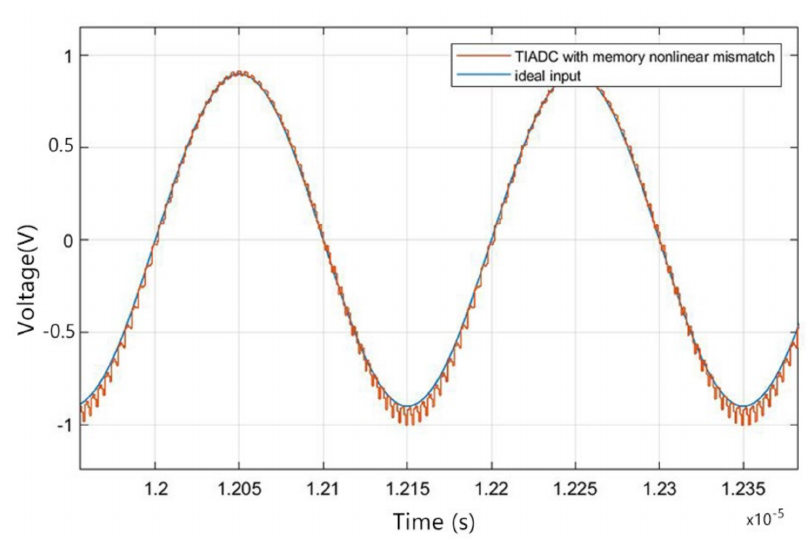
Figure 7. Time-domain figure of the TIADC model with memory nonlinearity